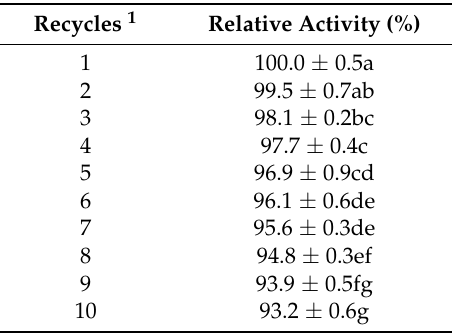
Table 2. Reusability of immobilized